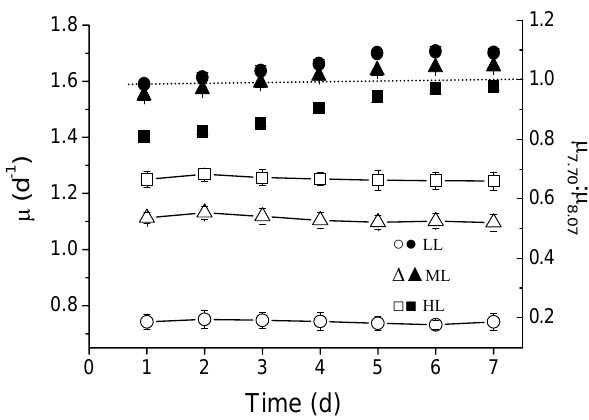
Figure 1. The specific growth rates (open symbols) of P. globosa grown at pH 8.07 and the ratios (solid symbols) of the specific growth rate at pH 7.70 to that at pH 8.07 ( µ 7 . 70 : µ 8 . 07 ) under dif- ferent irradiance levels (LL, 25; ML, 200; HL, 800µmol photons m − 2 s − 1 ). The data represent the mean ± SD ( n = 3, triplicate cul- tures).